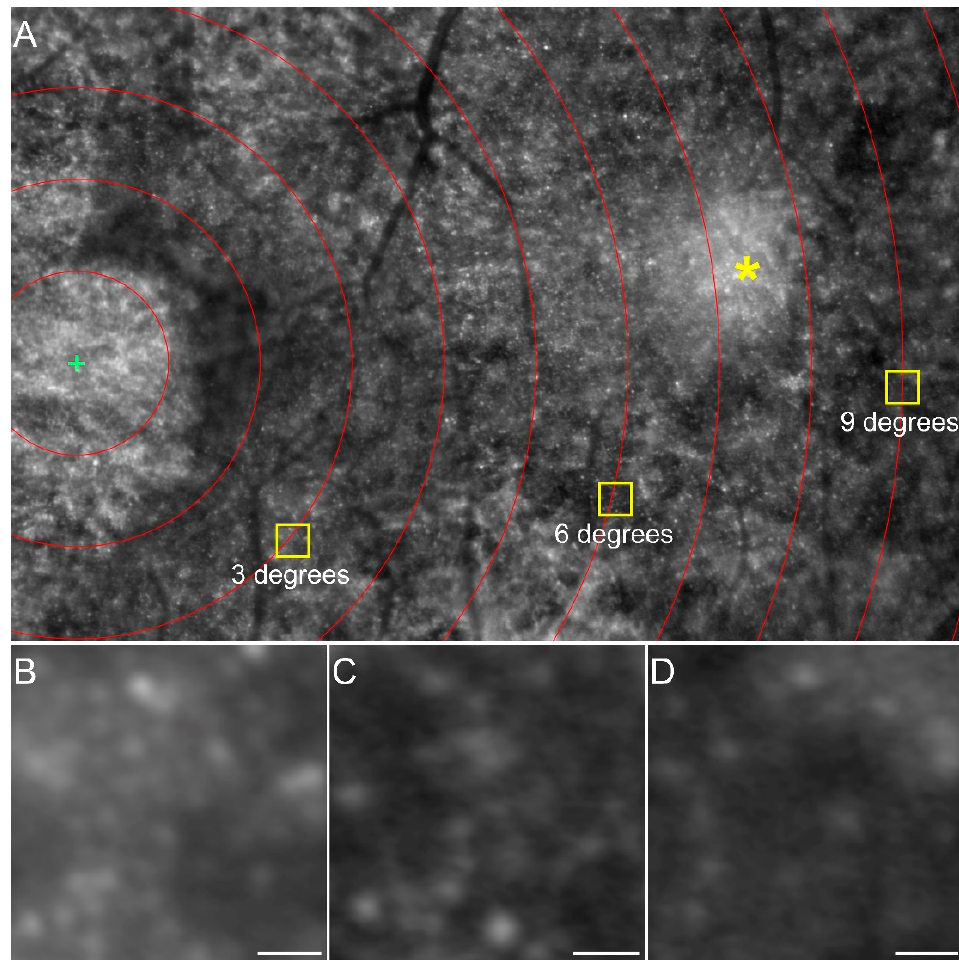
Figure 3. Example of the appearance of the cone mosaic on high magnification module imaging in a CACD patient ( A ). The green cross marks the location of the fovea. The red lines indicate corresponding retinal eccentricities. The yellow squares represent selected ROIs, depicted magnified at approximately 3 degrees ( B ), 6 degrees ( C ) and 9 degrees ( D ) from the fovea. An imaging artifact is marked by the asterisk. Scale bar: 20 µM.